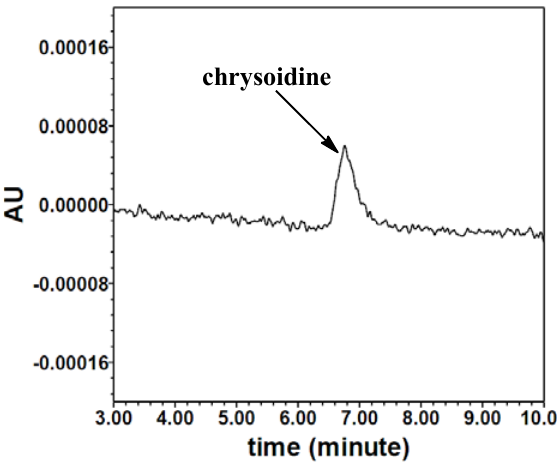
Figure 4. HPLC chromatogram of chrysoidine (10 ng/mL).